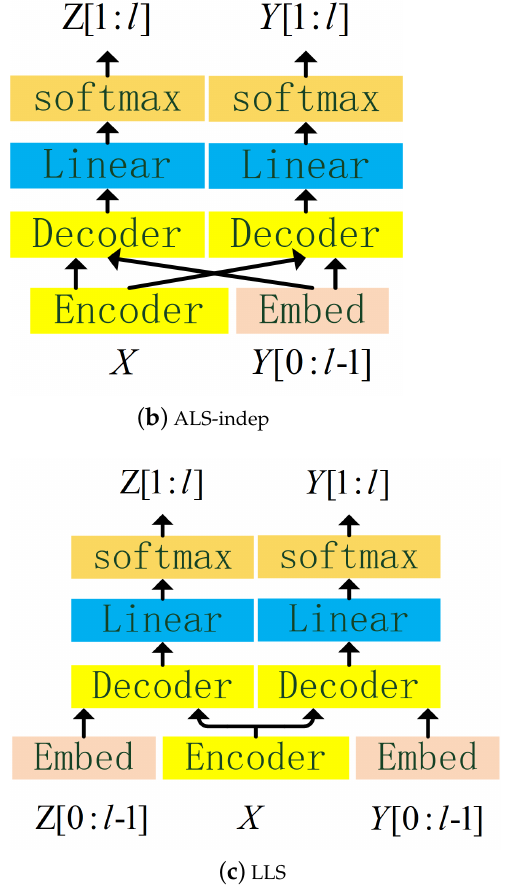
Figure 4. Frameworks for different MTL strategies.